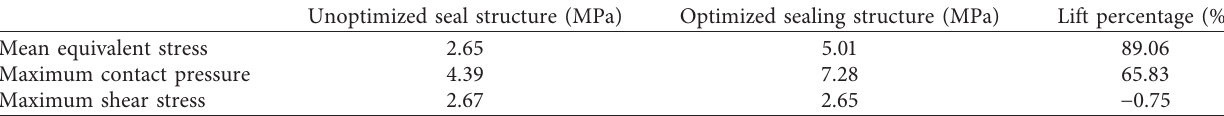
Table 6: Comparison of the optimised and unoptimised